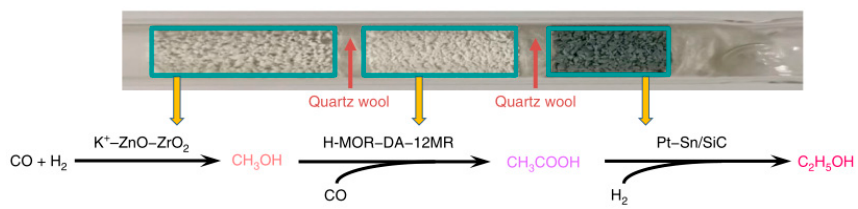
Figure 8. Possible reaction pathway for formation of ethanol in a triple tandem catalytic system. Adapted with permission from Nat. Commun. 2020, 11 , 827-838 [52]. Open access.